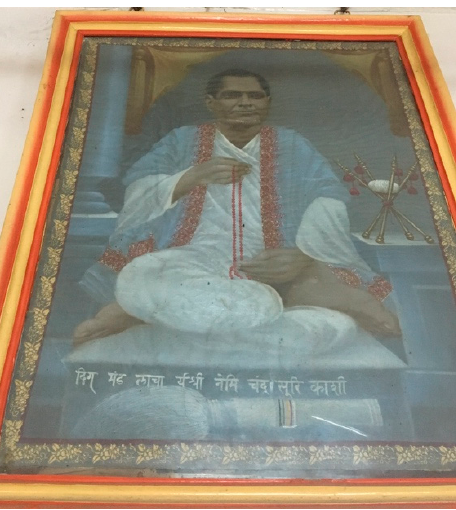
Figure 7. A painting of Ā c ā rya Nemicandras ū ri hung in the up āś raya of the Cint ā ma ṇ i P ā r ś van ā th Temple at R ā m Gh ā ṭ . Twentieth century.